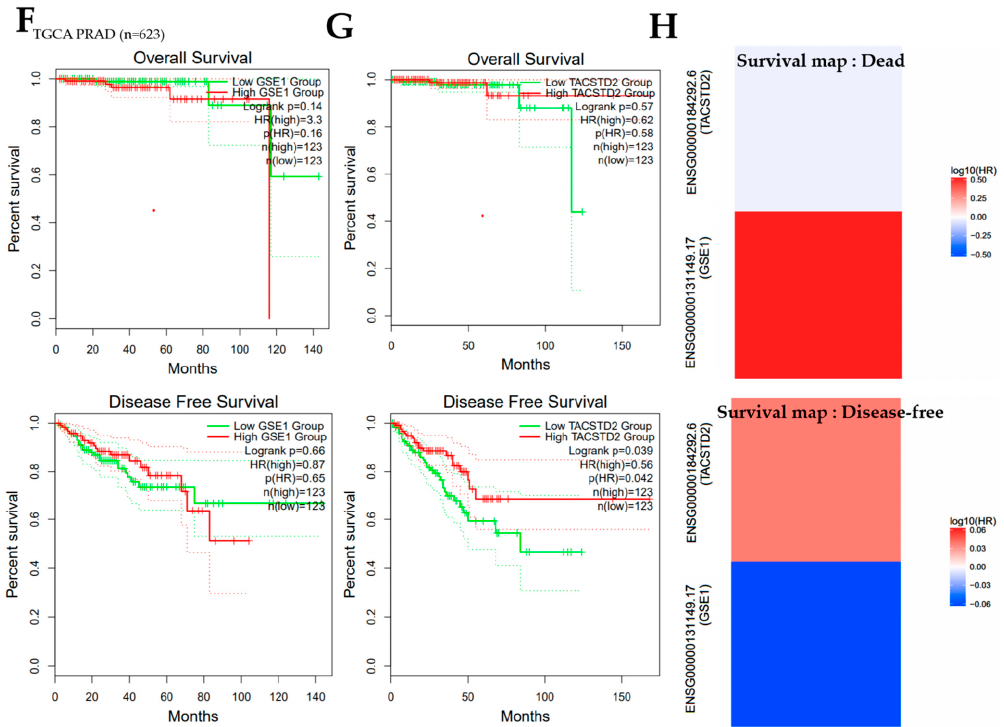
Figure 3 . Inversely correlated GSE1 and TACSTD2 expression patterns determine survival of patients with prostate cancer . ( A ) Correlation histograms for GSE1 and TACSTD2 expression pattern recognition in the GSE16560/GPL5474 PCa disease progression dataset. ( B ) Bubble charts of the convergent expression profile of GSE1 and TACSTD2 in the GSE16560/GPL5474 PCa cohort. ( C ) Kaplan–Meier curve showing the differential effects of GSE1 and TACSTD2 expression on overall survival in the pooled prostate cancer (DKFZ, Cancer Cell (2018))/prostate adenocarcinoma (MSKCC/DFCI, Nature Genetics (2018))/metastatic castration-sensitive prostate cancer (MSK, Clin Cancer Res (2020))/metastatic prostate adenocarcinoma (SU2C/PCF Dream Team, PNAS (2019)) cohort. Scatter plots showing the correlation between ( D ) TACSTD2 or ( E ) GSE1 mRNA expression and survival time in the pooled cohort. Kaplan–Meier curve showing the effect of the differential expression of ( F ) GSE1 or ( G ) TACSTD2 on overall survival ( top ) and disease-free survival ( bottom ). ( H ) Survival maps showing association between GSE1 or TACSTD2 with death or disease-free survival.